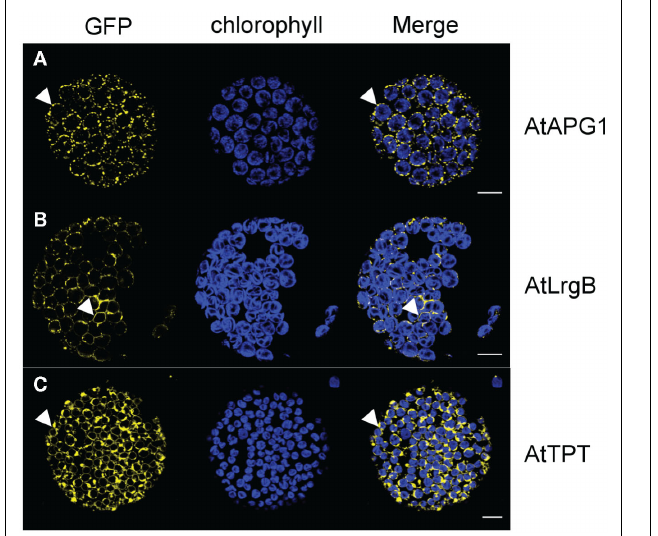
FIGURE 4 | GFP-fusion inner envelope protein expression patterns in N. benthamiana protoplasts. Confocal microscopic analysis on isolated protoplasts of N. benthamiana leaves after 35S-promoter driven in planta expression of GFP-fusion proteins. Pictures were taken 72h after infiltration. GFP fluorescence (GFP) in yellow, chlorophyll autofluorescence (chlorophyll) in blue and an overlay (merge) of representative protoplasts are shown. (A) Expression pattern of AtAPG1–GFP in dot structures associated with the chloroplast. (B) Expression pattern of AtLrgB–GFP in interrupted ring structures around the chlorophyll autofluorescence. (C) Expression pattern of AtTPT–GFP in circle structures with slide extensions proliferating from the circle. Size bars: 10 μ m.